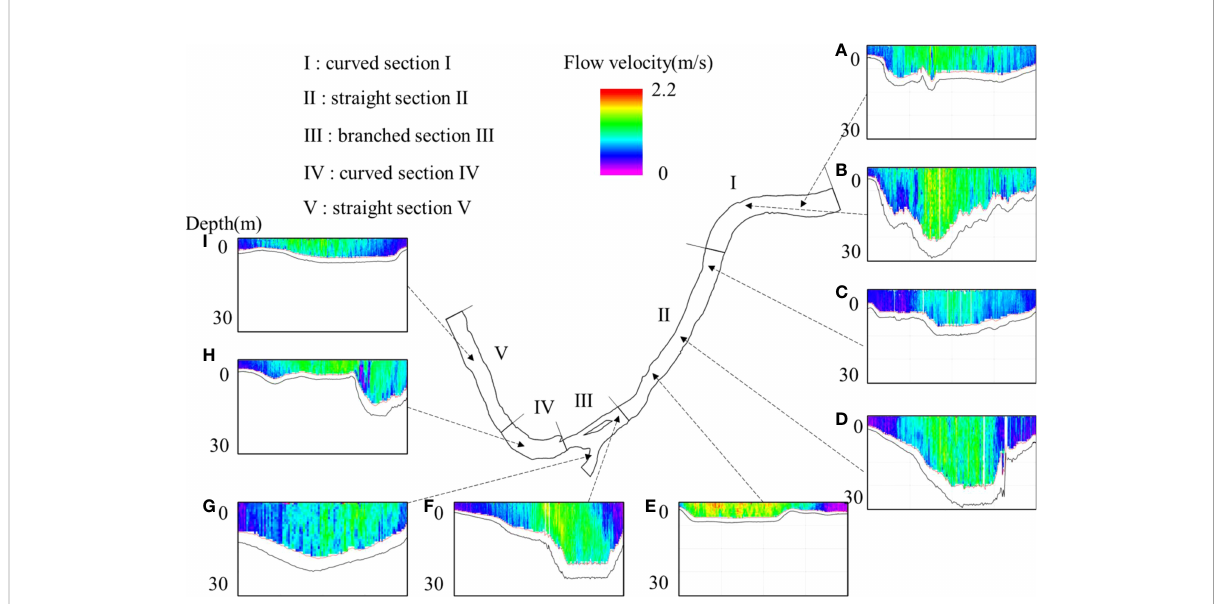
FIGURE 4 Plan and typical cross-sectional characteristics of the study area. (A – I) Directionally represent the downstream to upstream reaches along the study